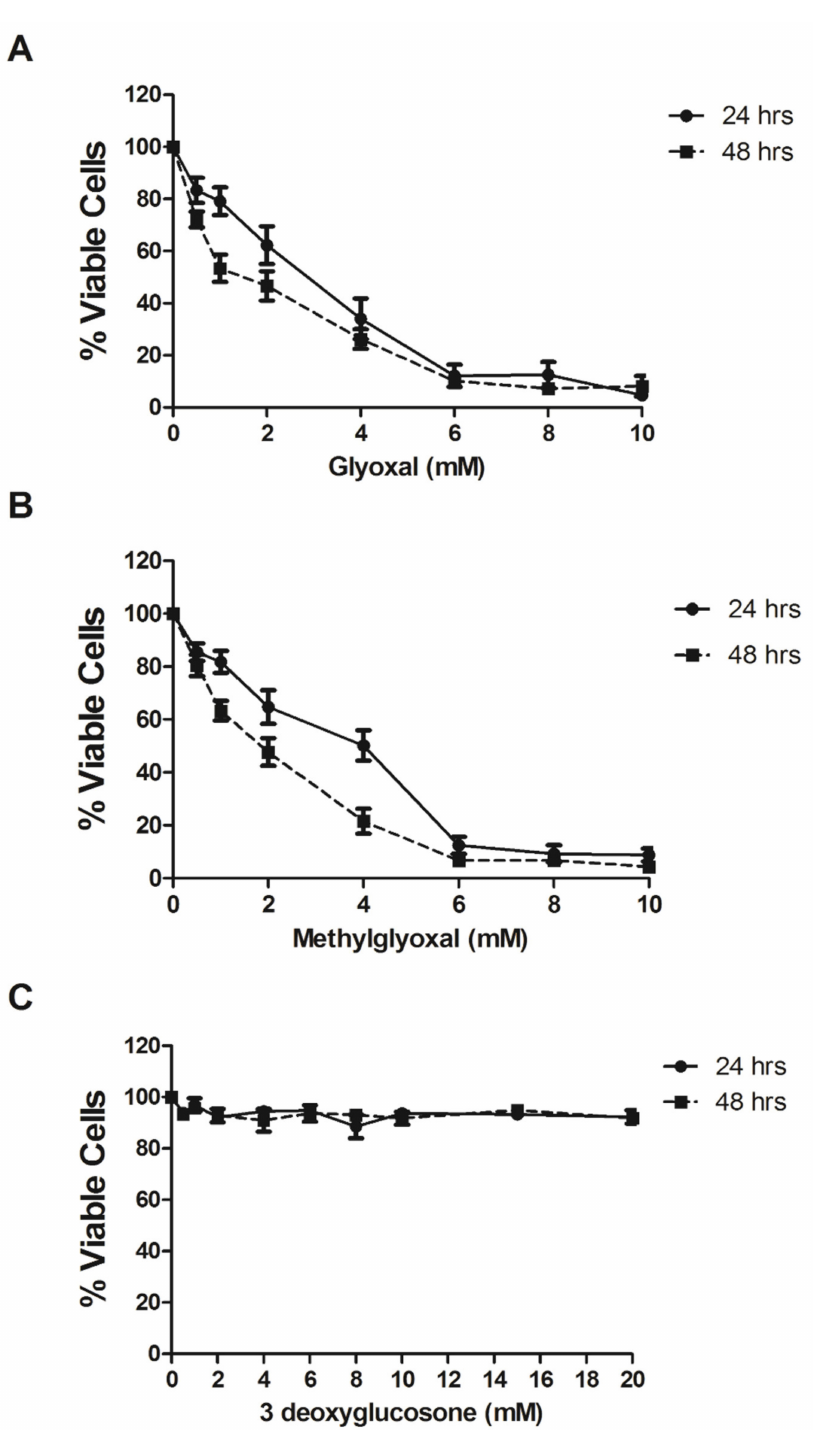
Figure 6. E ff ects of glyoxal, methylglyoxal and 3-deoxyglucosone on MCF-7 cell viability: Cells were treated for 24 ( • ) and 48 ( (cid:4) ) h with di ff erent glyoxal ( A ), methylglyoxal ( B ) or 3-deoxyglucosone ( C ) concentrations, and cell viability was determined by the MTT method. The results are representative of three experiments performed in triplicate ±